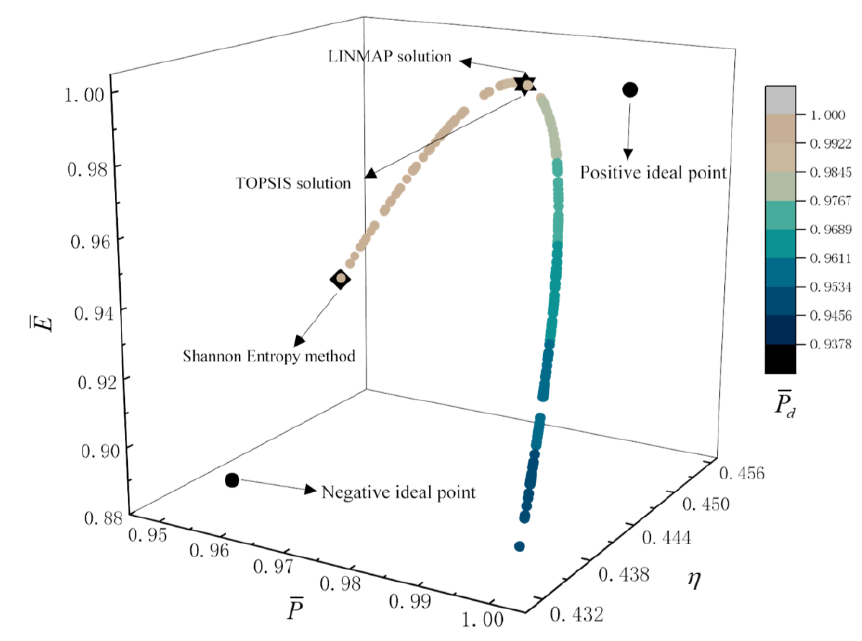
Figure 10. Quadru-objective optimization on P − η − E − P d